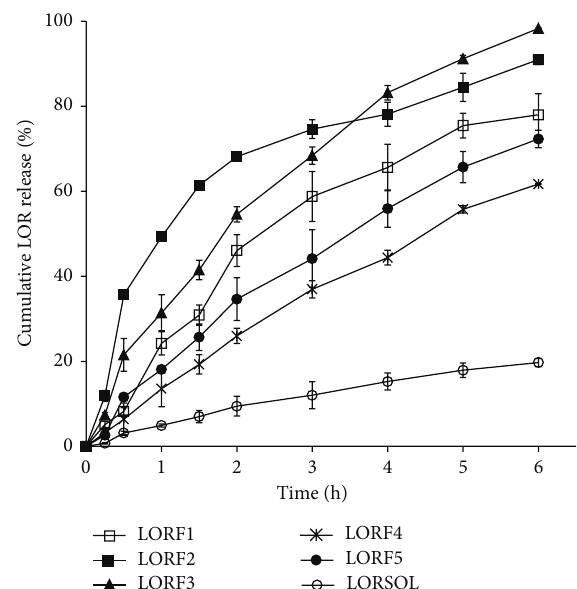
Figure 4: Cumulative amount of LOR released from different gel formulations. Data are presented as mean ± standard deviation ( 𝑛 = 3 ).